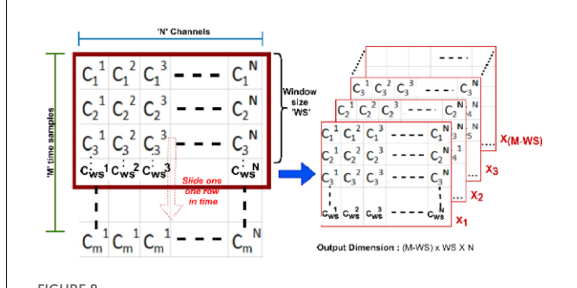
FIGURE9 The input data consisting of concentration changes of HbO and HbR in all channels. N for Dataset A varies as we did not have consistent number of channels for all subjects, but for Dataset B, N is 76 (36 for HbO channels and 36 for HbR channels). Time refers to window